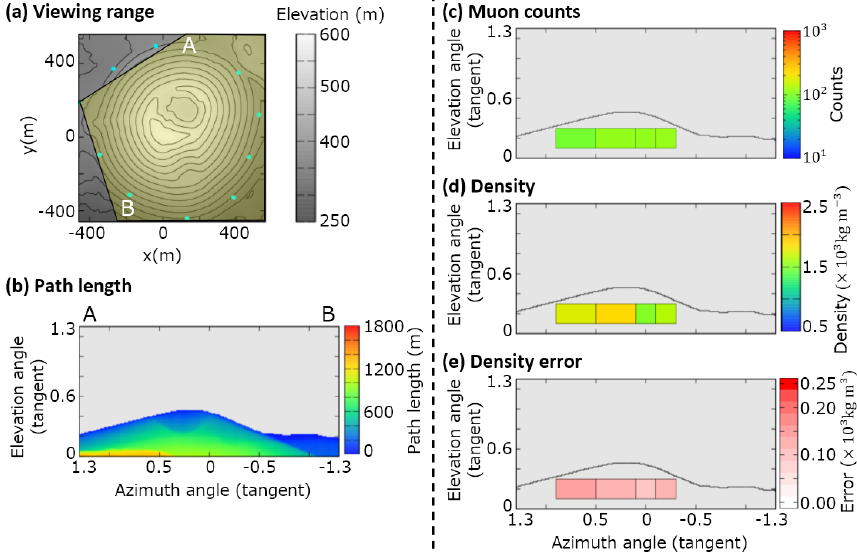
Figure B2. Observation site W. (a) Map, topography, and viewing range; (b) path length of the volcanic cone; (c) muon counts N obs density ρ i . The maximum value of the color bar indicates a density of > 2 . 5 × 10 3 kgm − 3 and the minimum value is < 0 . 5 × 10 3 kgm − 3 . (e) (cid:16) (cid:17) − ρ low ρ up / 2. The maximum value of the color bar indicates a density error of > 0 . 25 × 10 3 kgm − 3 . Density error (cid:49)ρ = i i